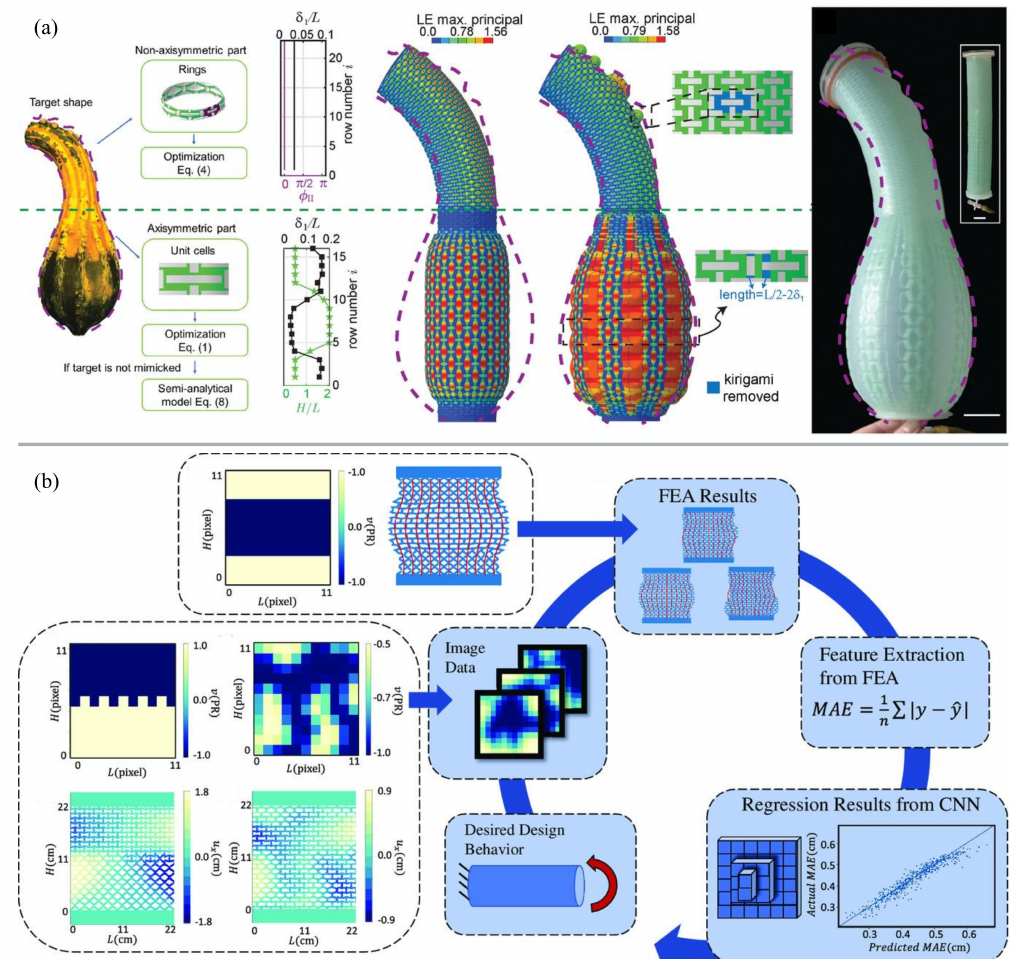
Figure 5. Examples of workflows for automated optimization of metamaterial systems. ( a ) Design of programmable inflatable actuators [80]; ( b ) optimization of auxetic material based on deep-learning [81]. Figures are reproduced and adapted with permission from John Wiley and Sons